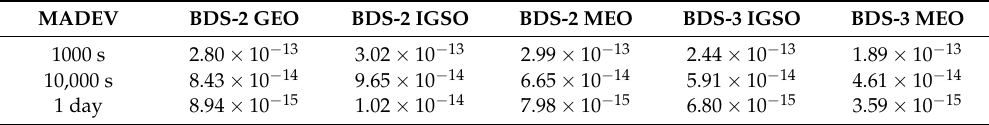
Table 7. Statistics of frequency stability of BDS-2 and BDS-3 satellite